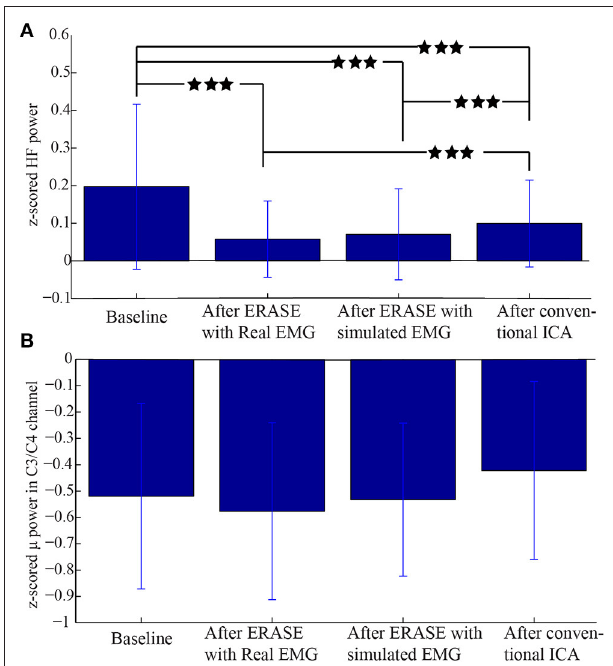
FIGURE 4 | Comparison of z-scored power of µ /high-frequency band during movement in different conditions. (A) z-scored power of high-frequency band during the movement for all the EEG channels under different conditions. (B) z-scored power of µ band during movement in the C3/C4 channel under different conditions. Data were from all the subjects with a total of 120 trials. ***Significant differences between the two datasets ( p <